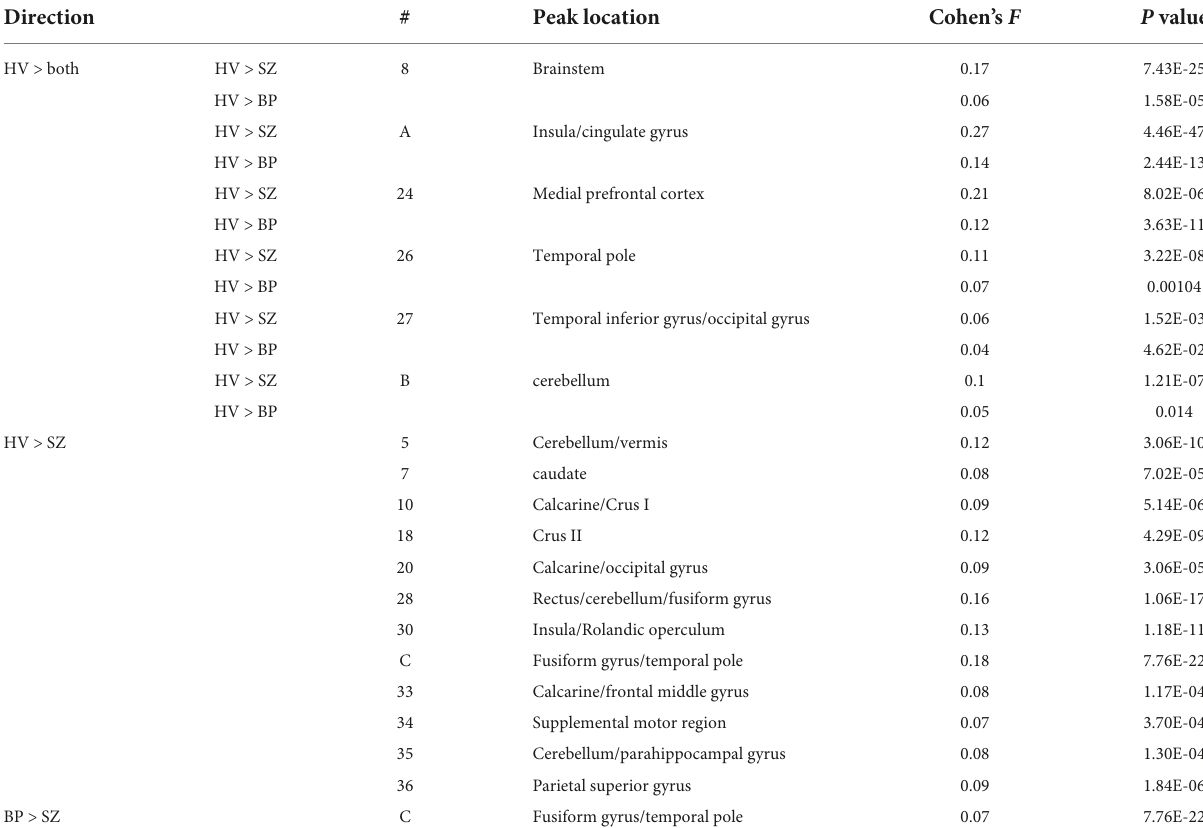
TABLE 3 Significant diagnostic group differences in the independent component analysis (ICA) components.